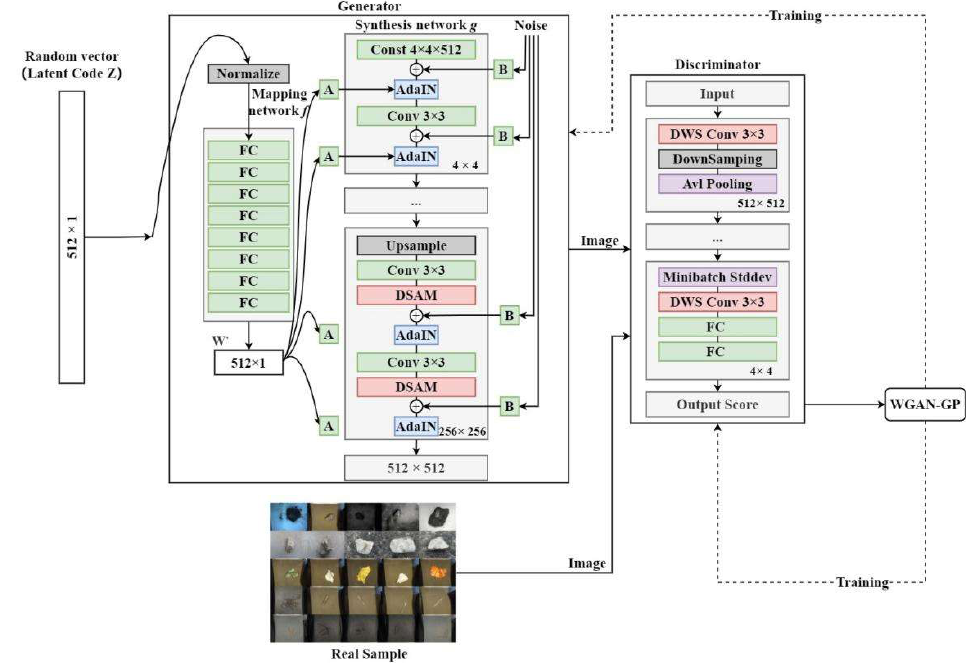
Figure 4. The network structure of StyleGAN-DSAD.